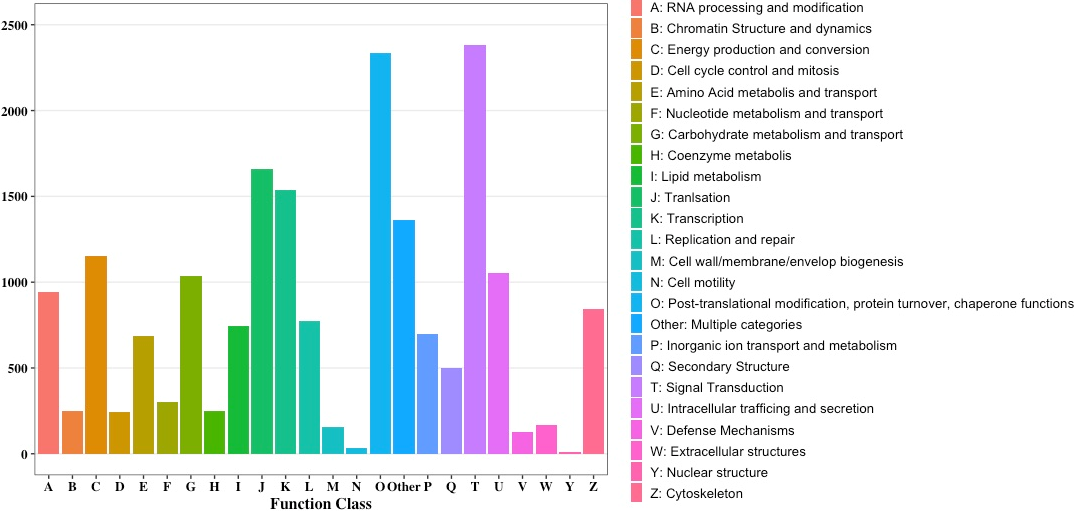
Figure 3. Histogram representing functional classification of adult I. calligraphus (Germar) unigenes into clusters of orthologous groups (COG). Table 3. Overview of putative RNAi machinery sequences and their similarity (E-value, bit score, and percent identity) to the top hit sequence when used as query for a BLASTx search using NCBIs nr database and their PANTHER classification identified using